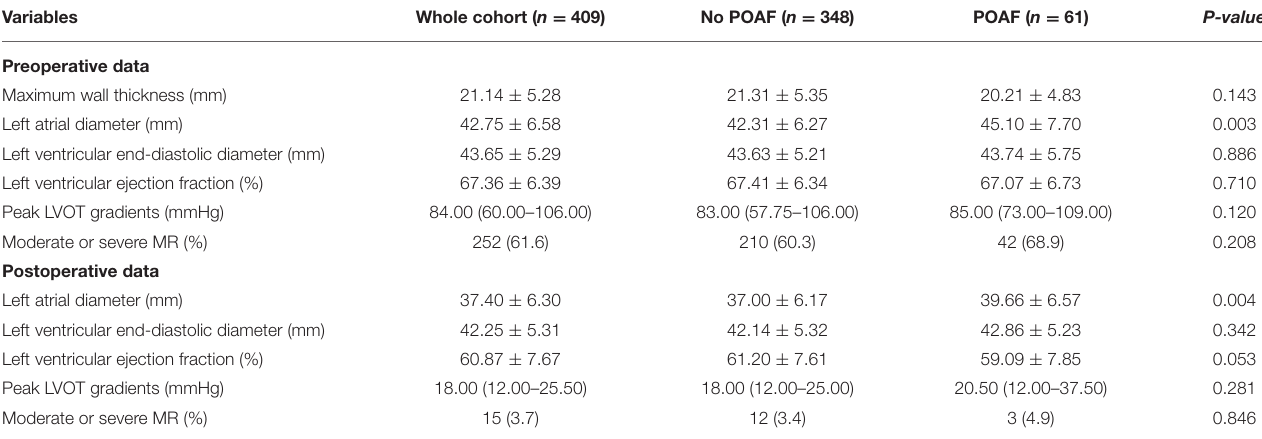
TABLE 2 | Perioperative echocardiographic variables of patients.